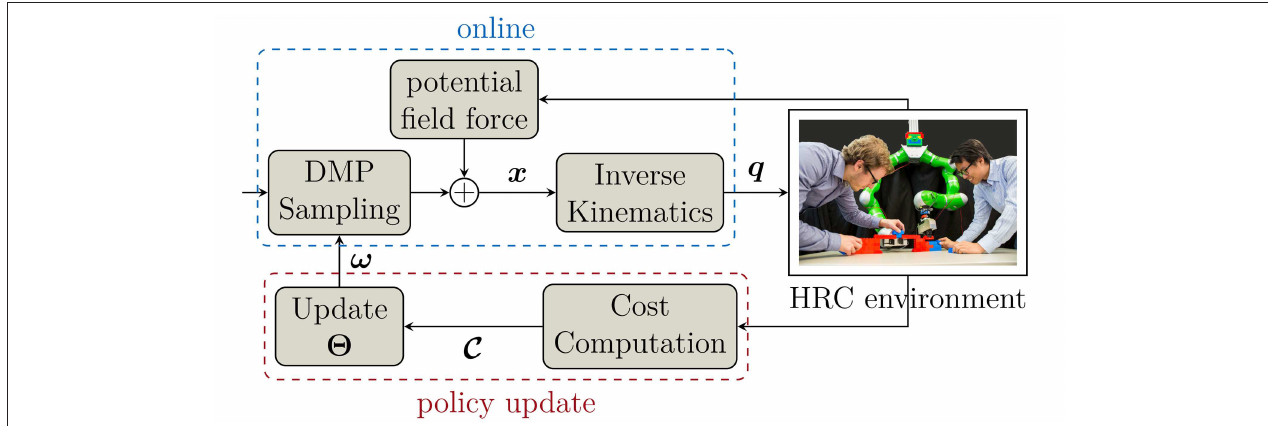
FIGURE 1 | Overview of the human-guided policy improvement framework. In each iteration, DMPs generate Cartesian trajectories x , which are converted to joint angles q using inverse kinematics. During interaction, potential field force is added to modify the trajectories online to provide safety when the human gets close to the robot. After execution, a cost function C is evaluated to update the policy 2 of the DMPs using PIBBO for the next